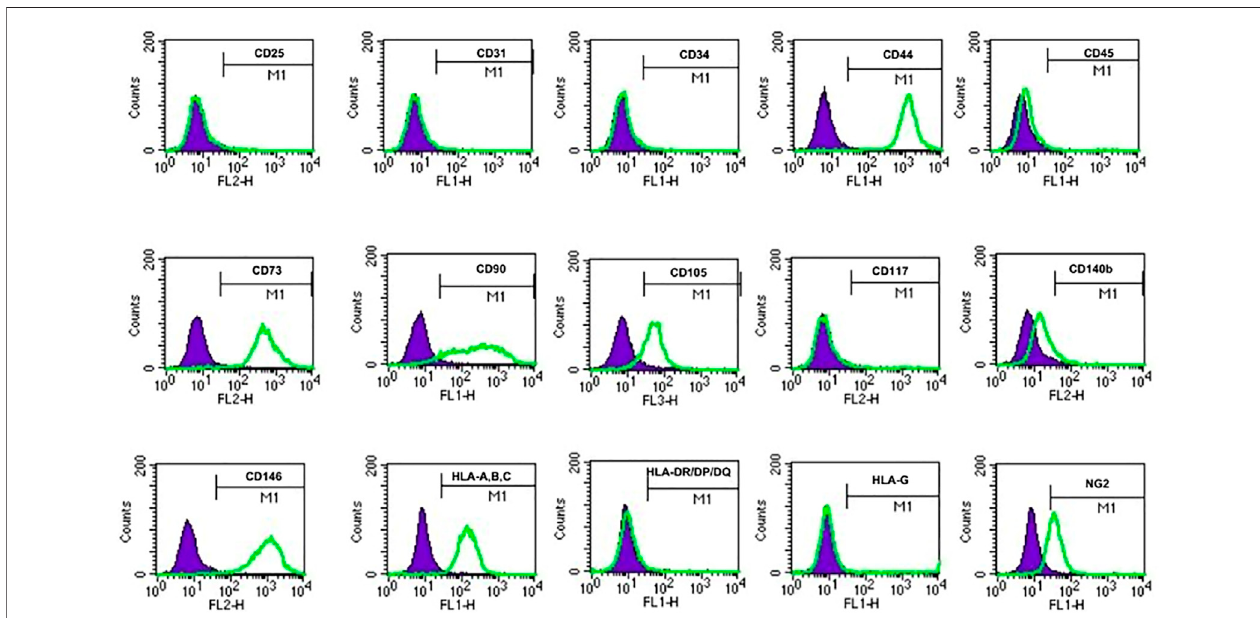
FIGURE6| USCsexpressingmesenchymalstemcellsurfacemarkers.USC TA+ clones(A35,B36,G1,E37,J29,andK5)andUSC TA − clones(A42,B31,G12,E34, J18, and K6) both displayed sets of mesenchymal stem cell (MSC) surface markers (CD44, CD90, CD73, CD105, and CD146), positive at similar levels, whereas both USCs TA+ and USCs TA − did not express setsofhaemopoietic stemcellmarkers(i.e.,CD31,CD34, CD45,CD25,and CD117). However,three of fi veUSCs TA+ displayed CD105 expression, but no or weak expression in all the four USC TA − cell clones. MSC surface markers of USCs at p4 were detected via fl ow cytometry.